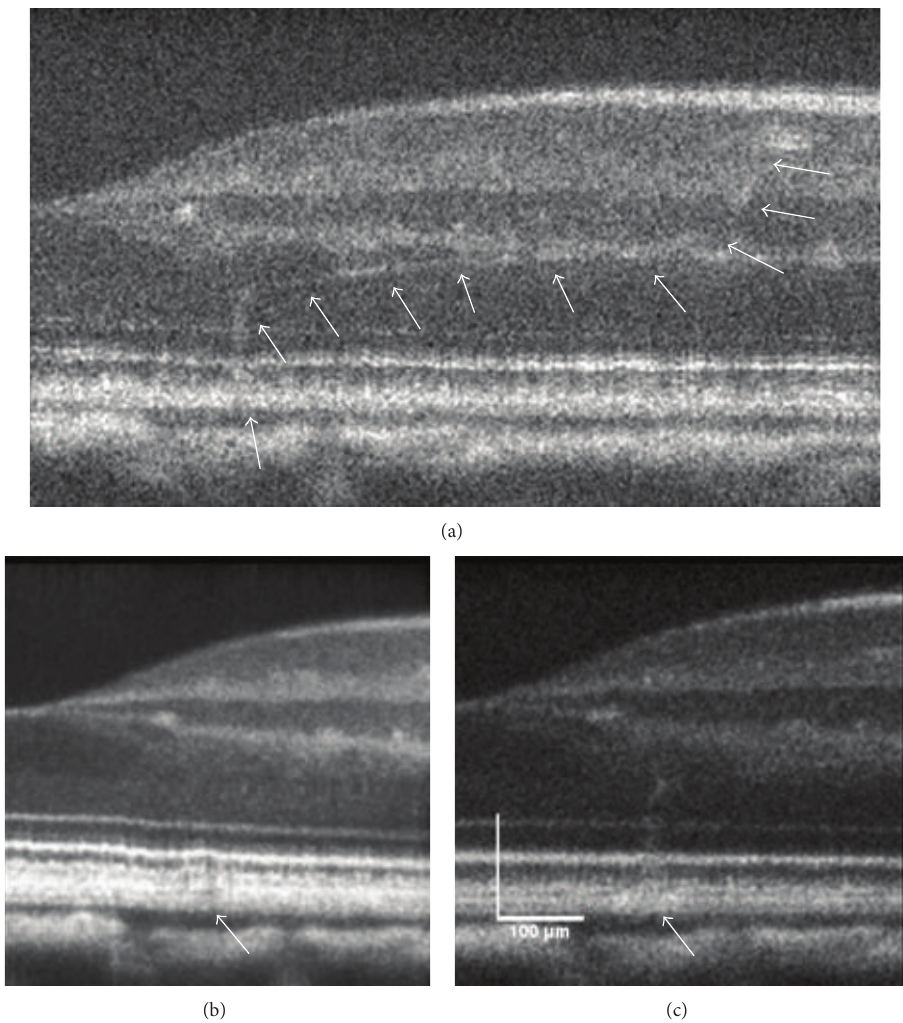
Figure 6: OCT B-scans of the retina of subject S8 OD (a) 1 hour, (b) 24 hours, and (c) 7 days following moderate (325 mJ/cm 2 ) 532 nm 40ps exposure. White arrows in (a)–(c) denote lesion base. Within minutes following exposure, a hyperreflective thread-like structure appears and extends from the lesion site up to a blood vessel (white arrows). Damage to the RPE layer becomes more hyperreflective and distinguishable over a 24-hour period. One week later, the photoreceptor layer protrudes slightly at the exposure site. Scale bar: 100 𝜇 m.